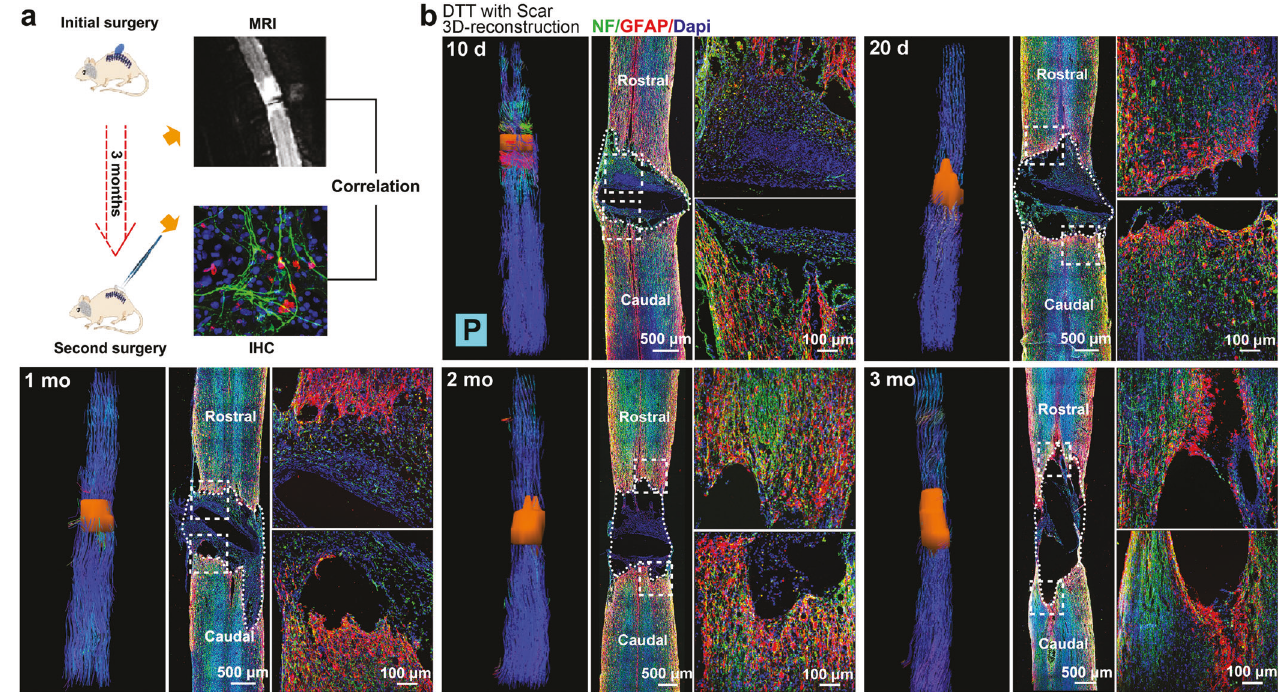
Fig. 1 Noninvasive monitoring of lesion progression. a Schematic diagram of MRI-DTI imaging to identify lesion area in spinal cord tissue. After the initial operation, a series of MRI-DTI scans were performed at 10 days, 20 days, 1 month, 2 months, and 3 months post-surgery. b Diffusion tensor tractography (DTT) images with 3D reconstructed models of lesion area and corresponding immunohistochemistry of the same cord after DTT analyses at different time points post-surgery. P means